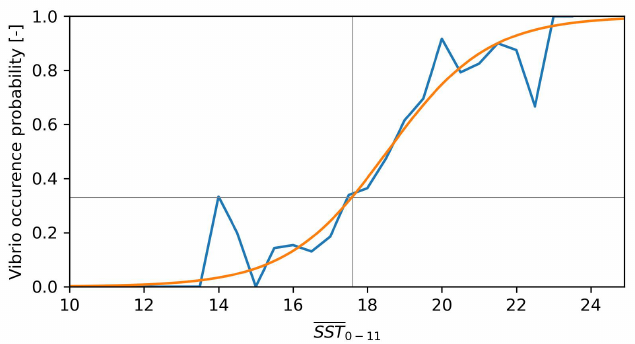
Figure A1. Probability of the V. vulnificus occurrence over SST mean 0–11 . The blue line shows the proba- bility of occurrence of all samples calculated per 0.5 °C and the orange line is the logistic regression.